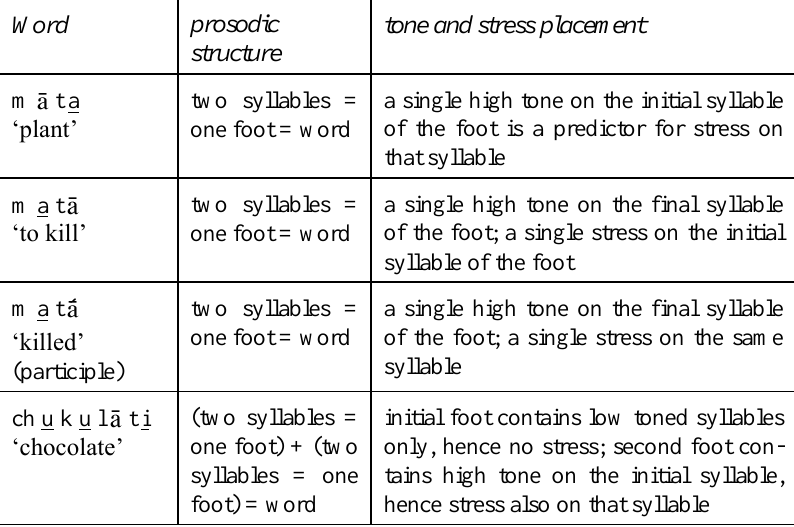
Table 4. Distribution of tone and stress in Pp words, after